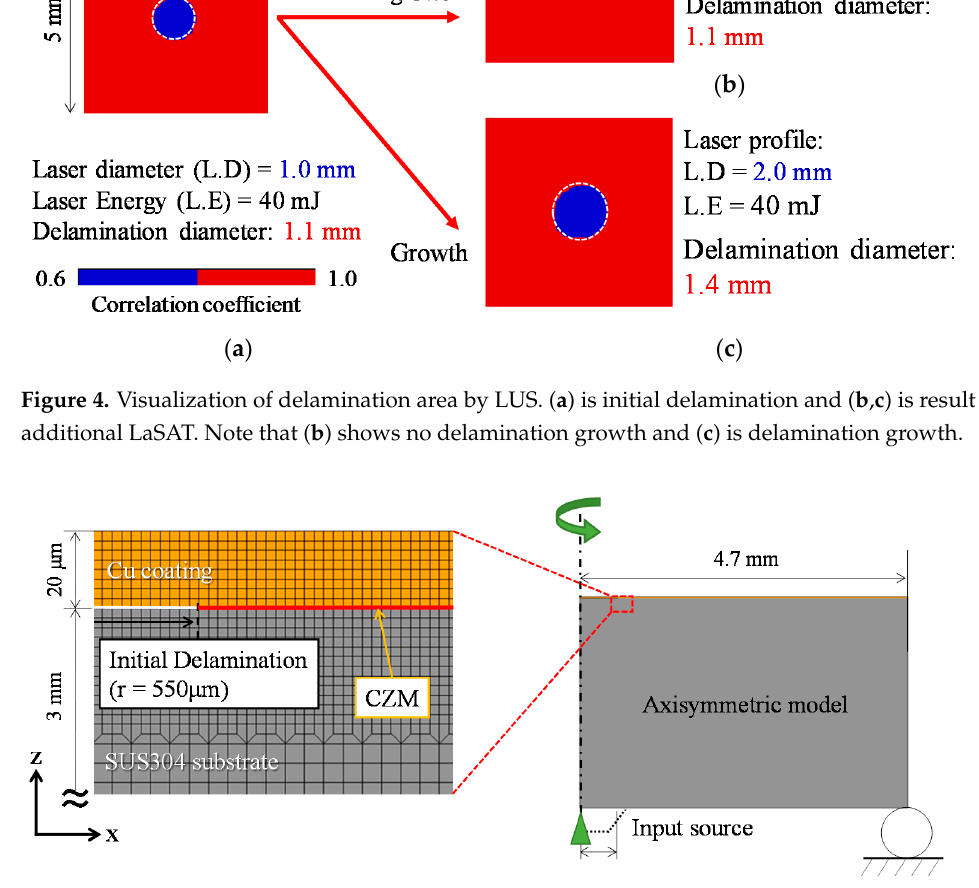
Figure 5. Finite element method (FEM) model of coating and substrate with Cohesive Zone Model (CZM).